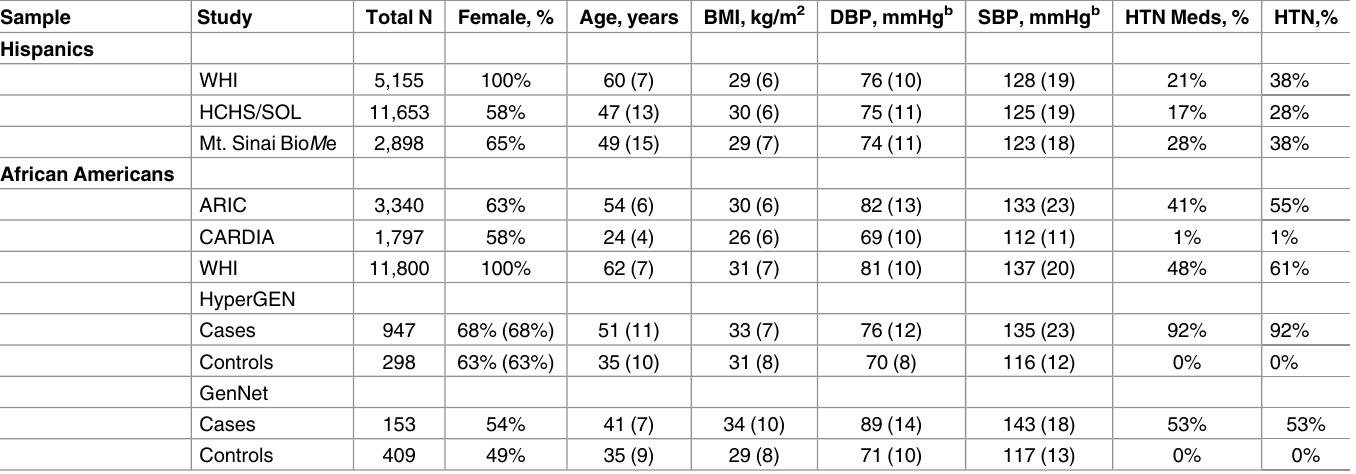
Table 1. Descriptivecharacteristics a of the PAGE and FBBP studies by race/ethnicity. Sample